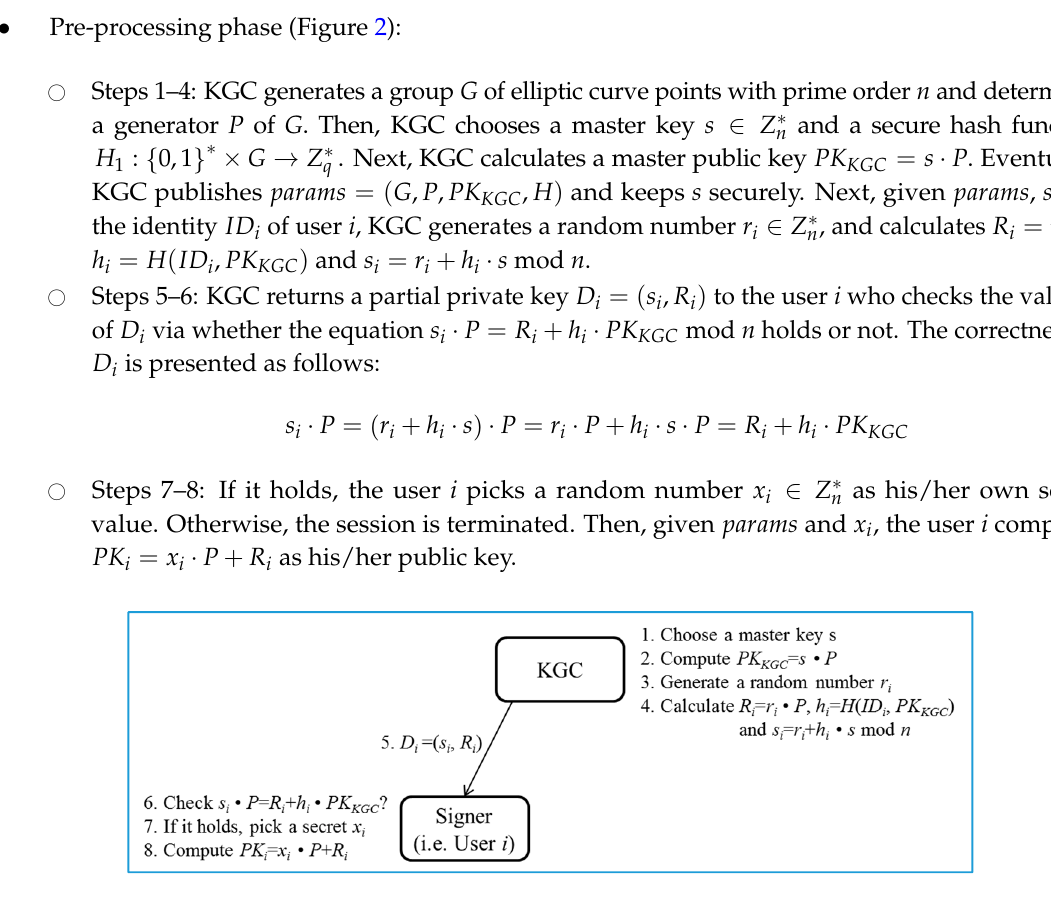
Figure 2. Pre-processing phase of the proposed certificateless signature scheme.